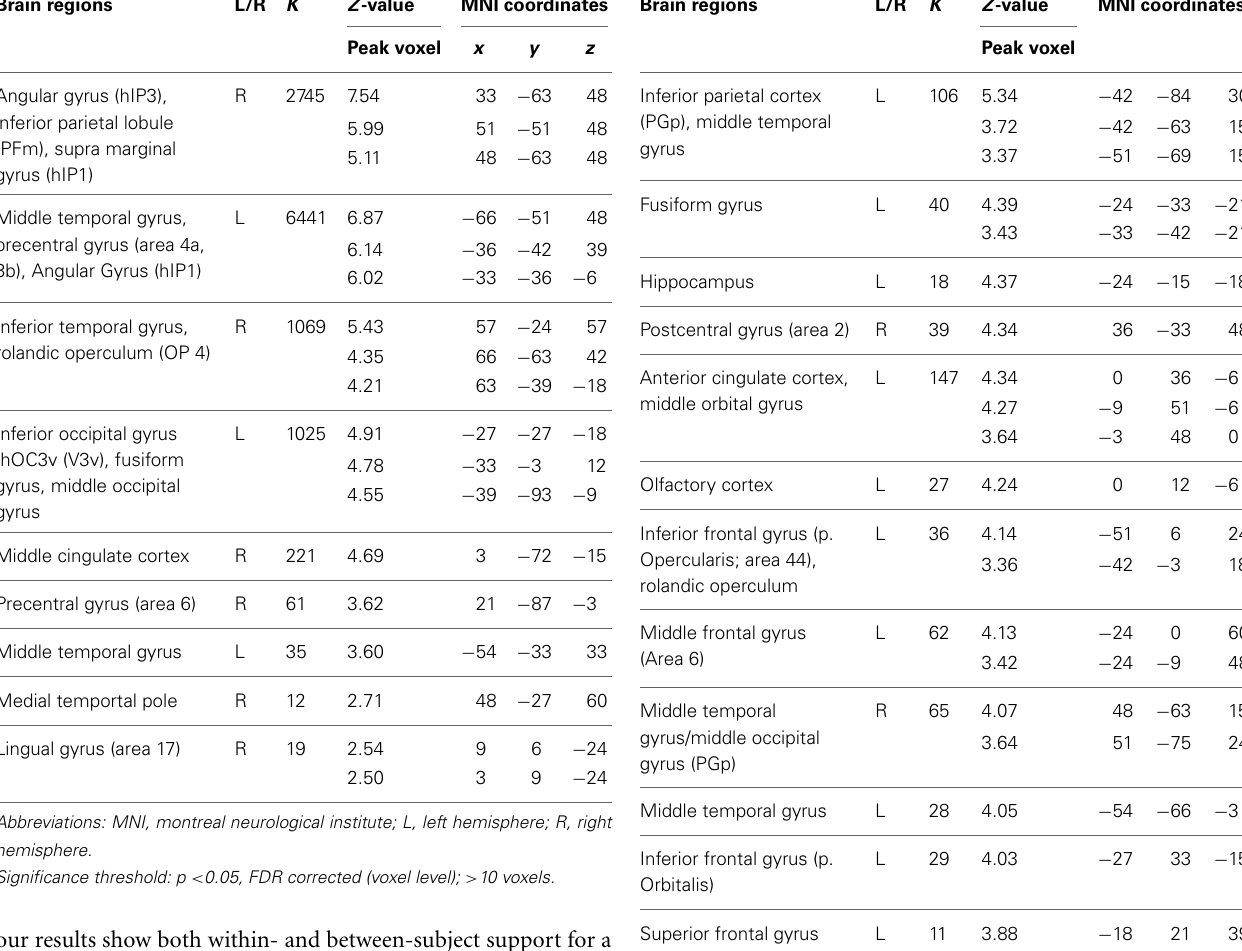
Table 4 | Neural activations for the contrast OC > AU. Brain regions